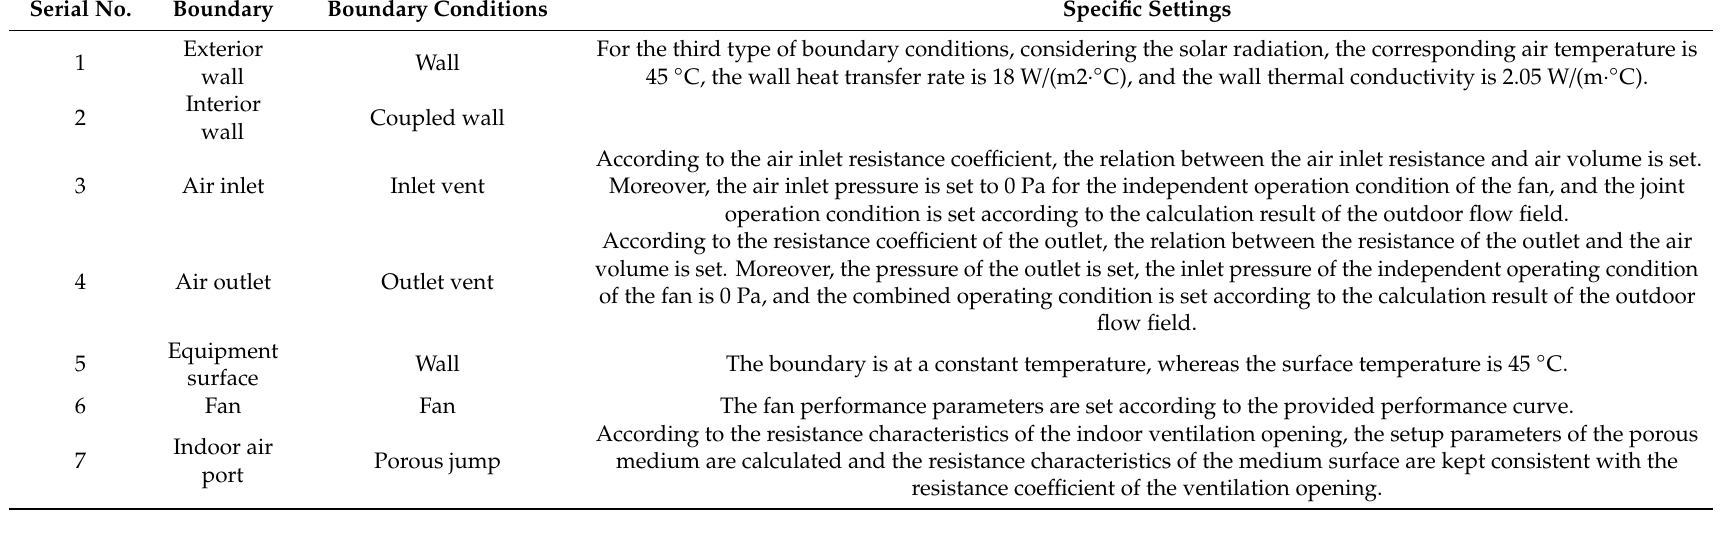
Table 8. Boundary conditions settings.